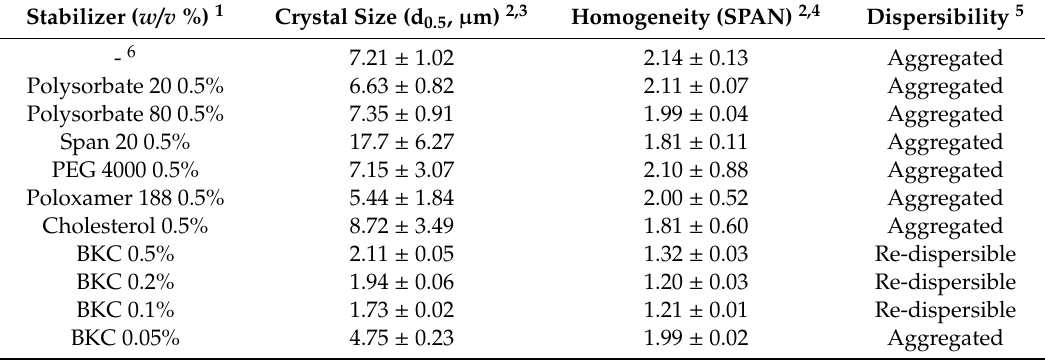
1 Weight per volume concentration in ACN. 2 Expressed as mean ± SD ( n = 3). 3 Indicates the volume weighted diameter below which 50% of the total particle. 4 Calculated by dividing the difference between d 0.9 and d 0.1 by d 0.5 . d 0.9 and d 0.1 indicate the volume weighted diameters below which 90% and 10% of the total particle, respectively. 5 Visually evaluated after 24 h storage at room temperature. 6 Indicates without stabilizer. Table 1. E ff ects of kinds of stabilizers on size, homogeneity, and dispersibility of TA microcrystals in ACN.